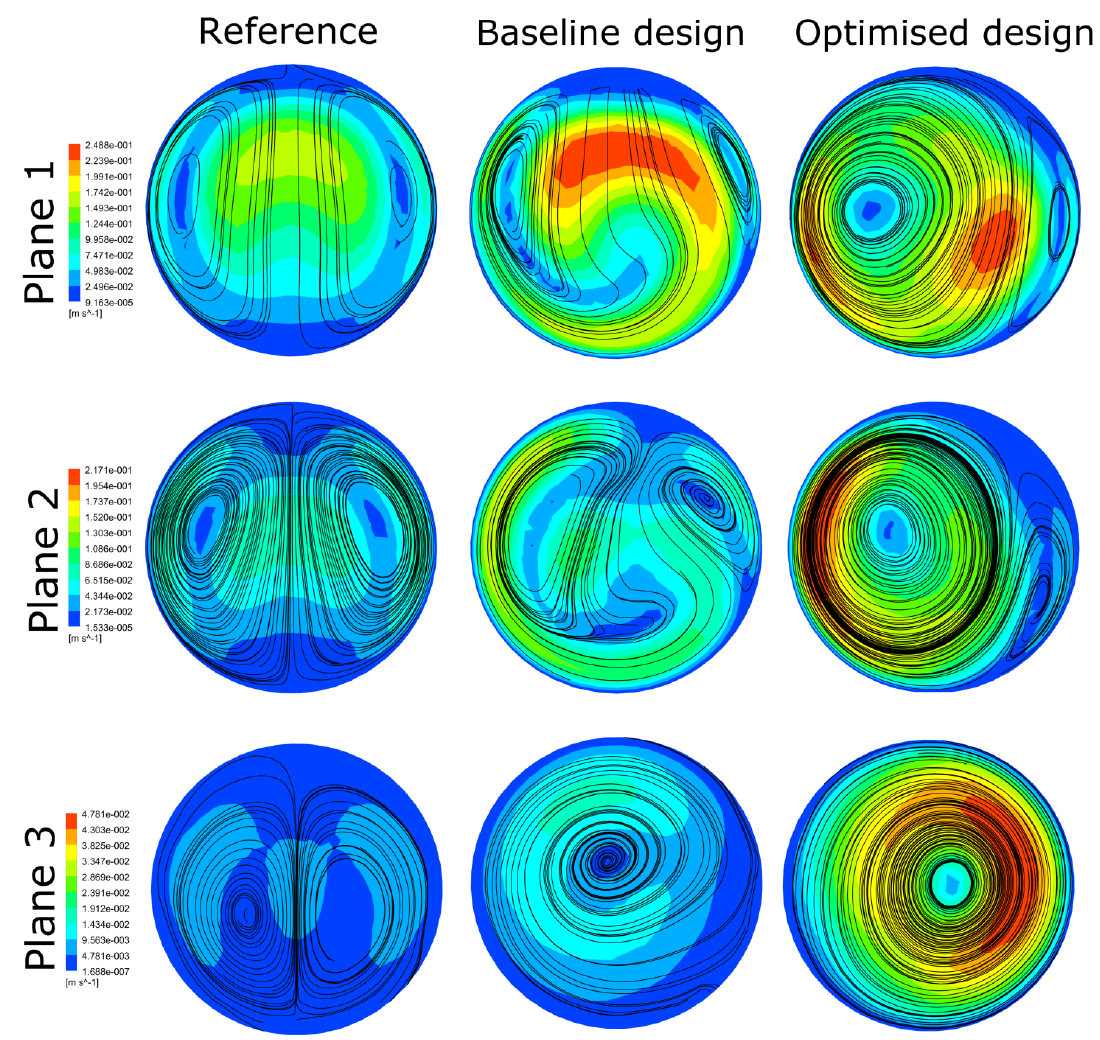
Figure 4. Secondary velocity profiles in three monitoring planes positioned 2 mm, 6 mm, and 50 mm after the anastomosis.